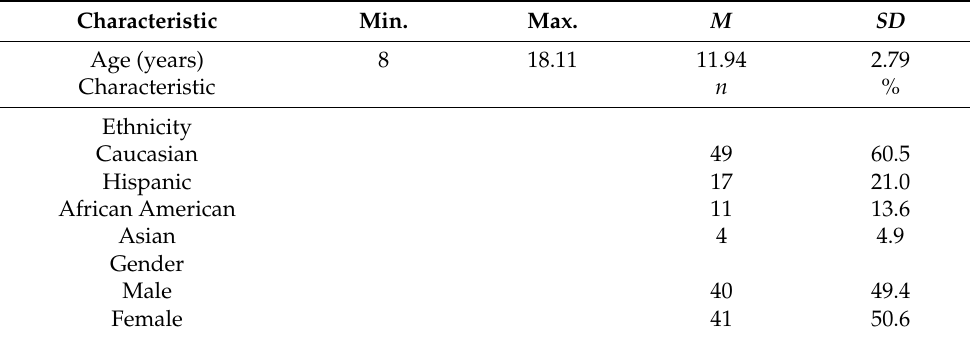
Table 1. Demographic characteristics of